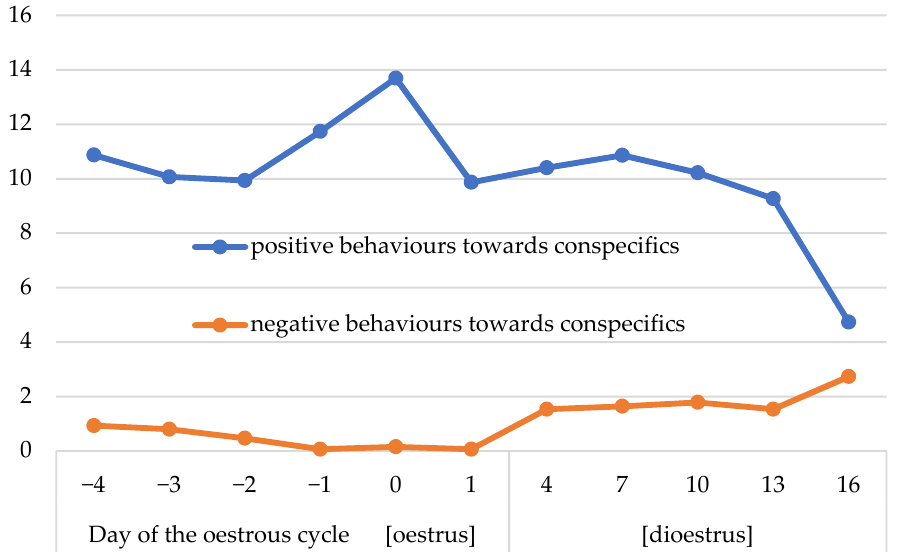
Figure 5. Dynamics of changes in mean scores for the frequency of positive and negative behaviours towards conspecifics in the morning during the oestrous cycle.